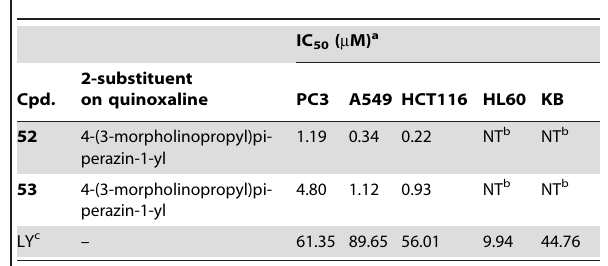
Table 3. Antiproliferative activity of piperazinylquinoxalines